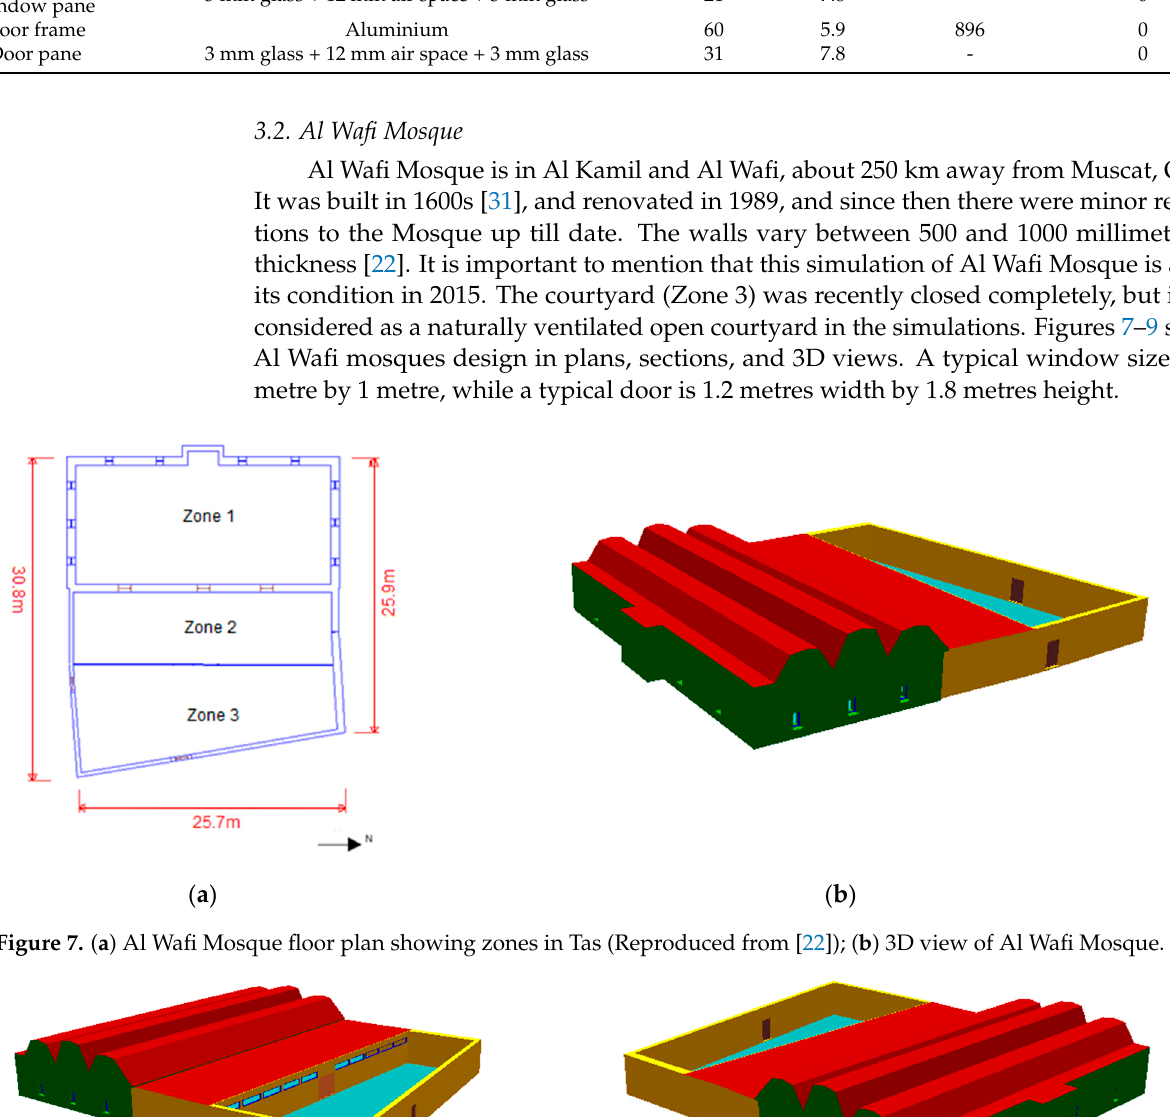
Table 3. Construction details of Hudhayfah mosque.